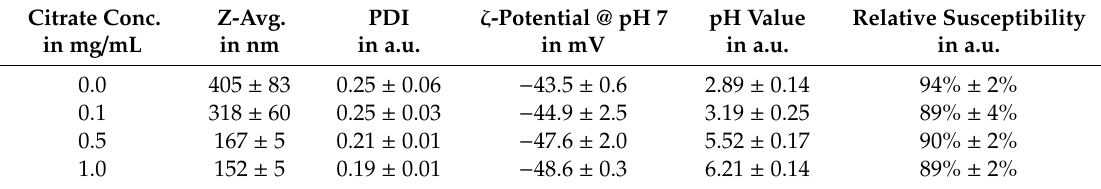
Figure 5. Influence of the citrate concentration in Cit-Au-SPION dispersions on ( a ) the Z-average and ( b ) the particle stability during 21 days of storage at 4 °C. Statistically significant changes are marked with * for p < 0.05. Table 2. Comparison of the basic parameters of Cit-Au-SPIONs with varied citrate concentrations. Citrate Conc.